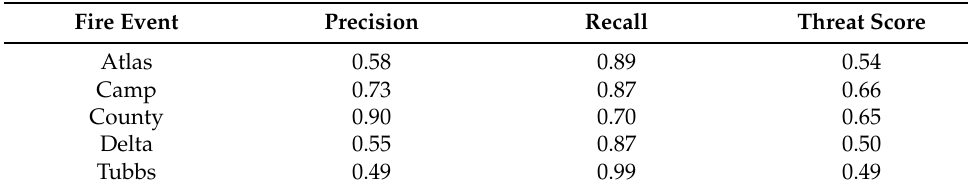
Table 3. Performance metrics computed for the fire isochrone closest in time to the available GeoMAC perimeters. TP, true positive; FP, false positive; FN, false negative. Precision = TP/(TP +